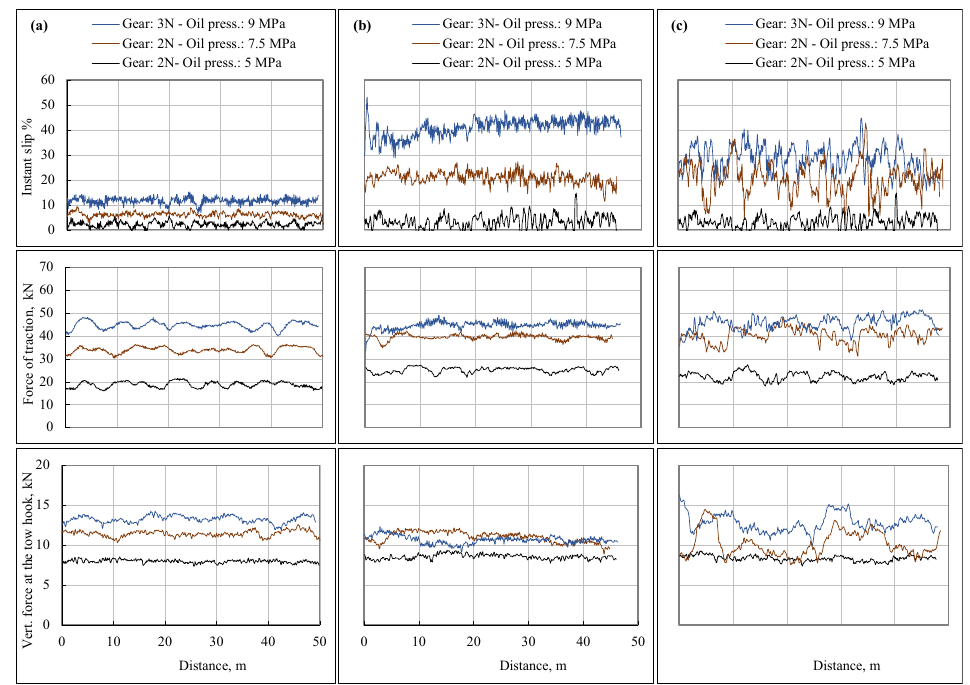
Figure 5. Effects of different regulations of the MTB braking system on the behaviours of slip, force of traction and vertical force on the tow-hook. ( a ) Asphalt; ( b ) seedbed; ( c ) headland with grass cover. Under constant conditions of gear box ratios and oil pressure, varying the test surface determines clear differences.